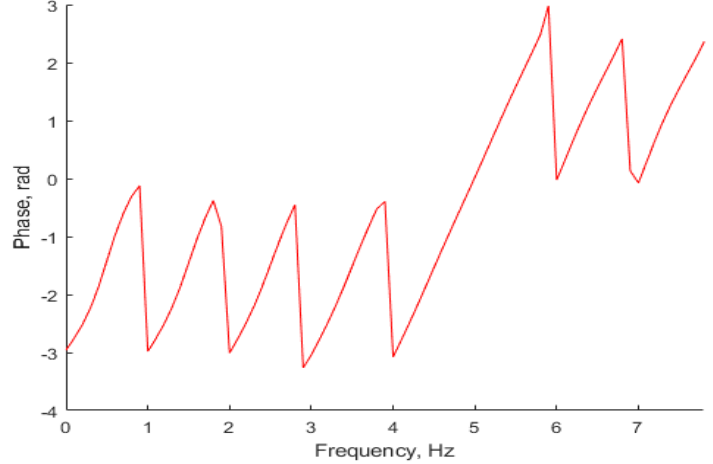
Figure 5. Magnitude response of the DFT and NC channels.